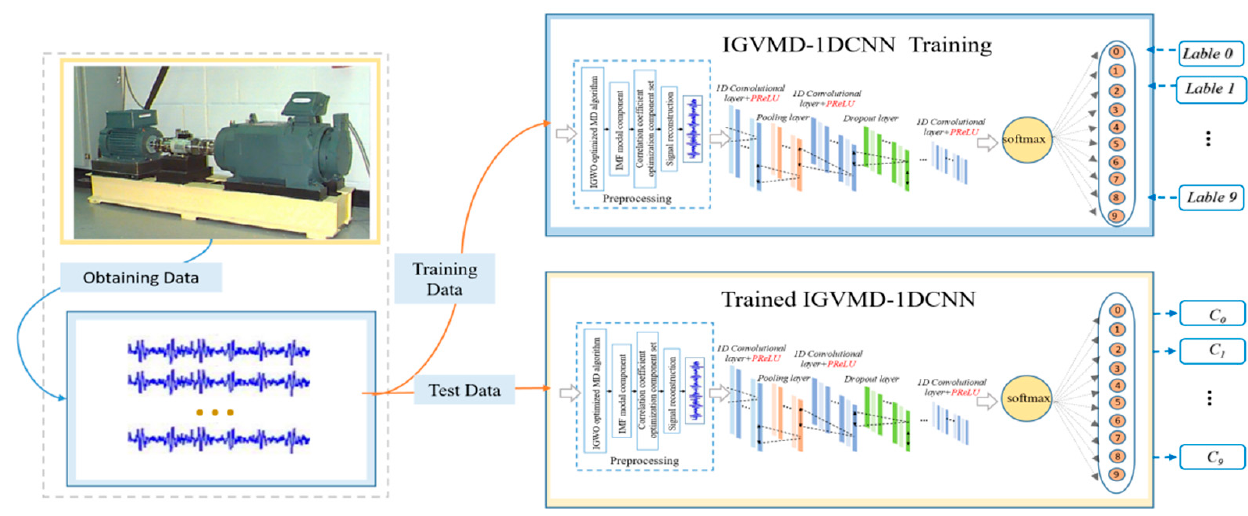
Figure 5. The flow chart of rolling bearing fault diagnosis.